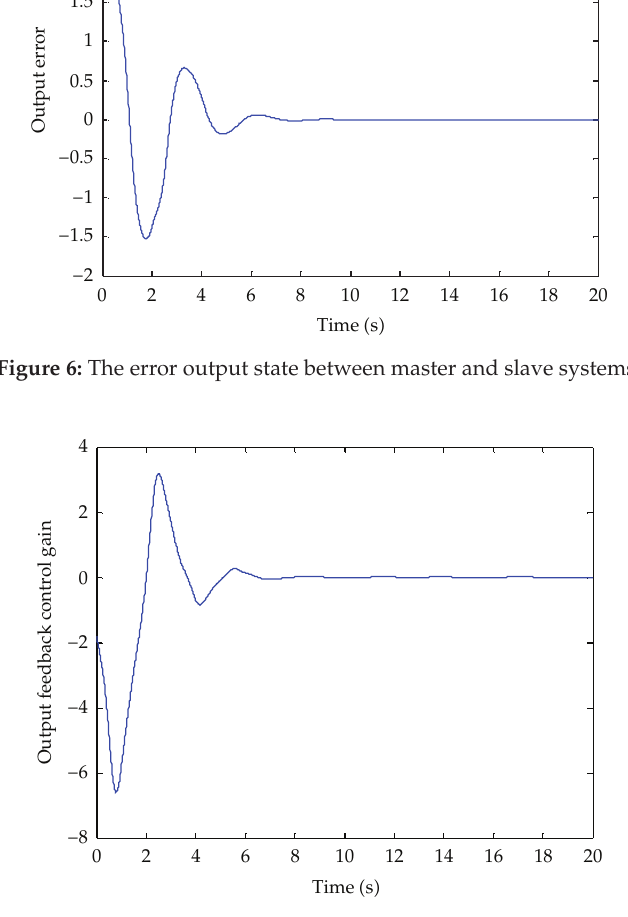
Figure 7: The output feedback control gain of L (cid:2) y − (cid:4) y (cid:3)